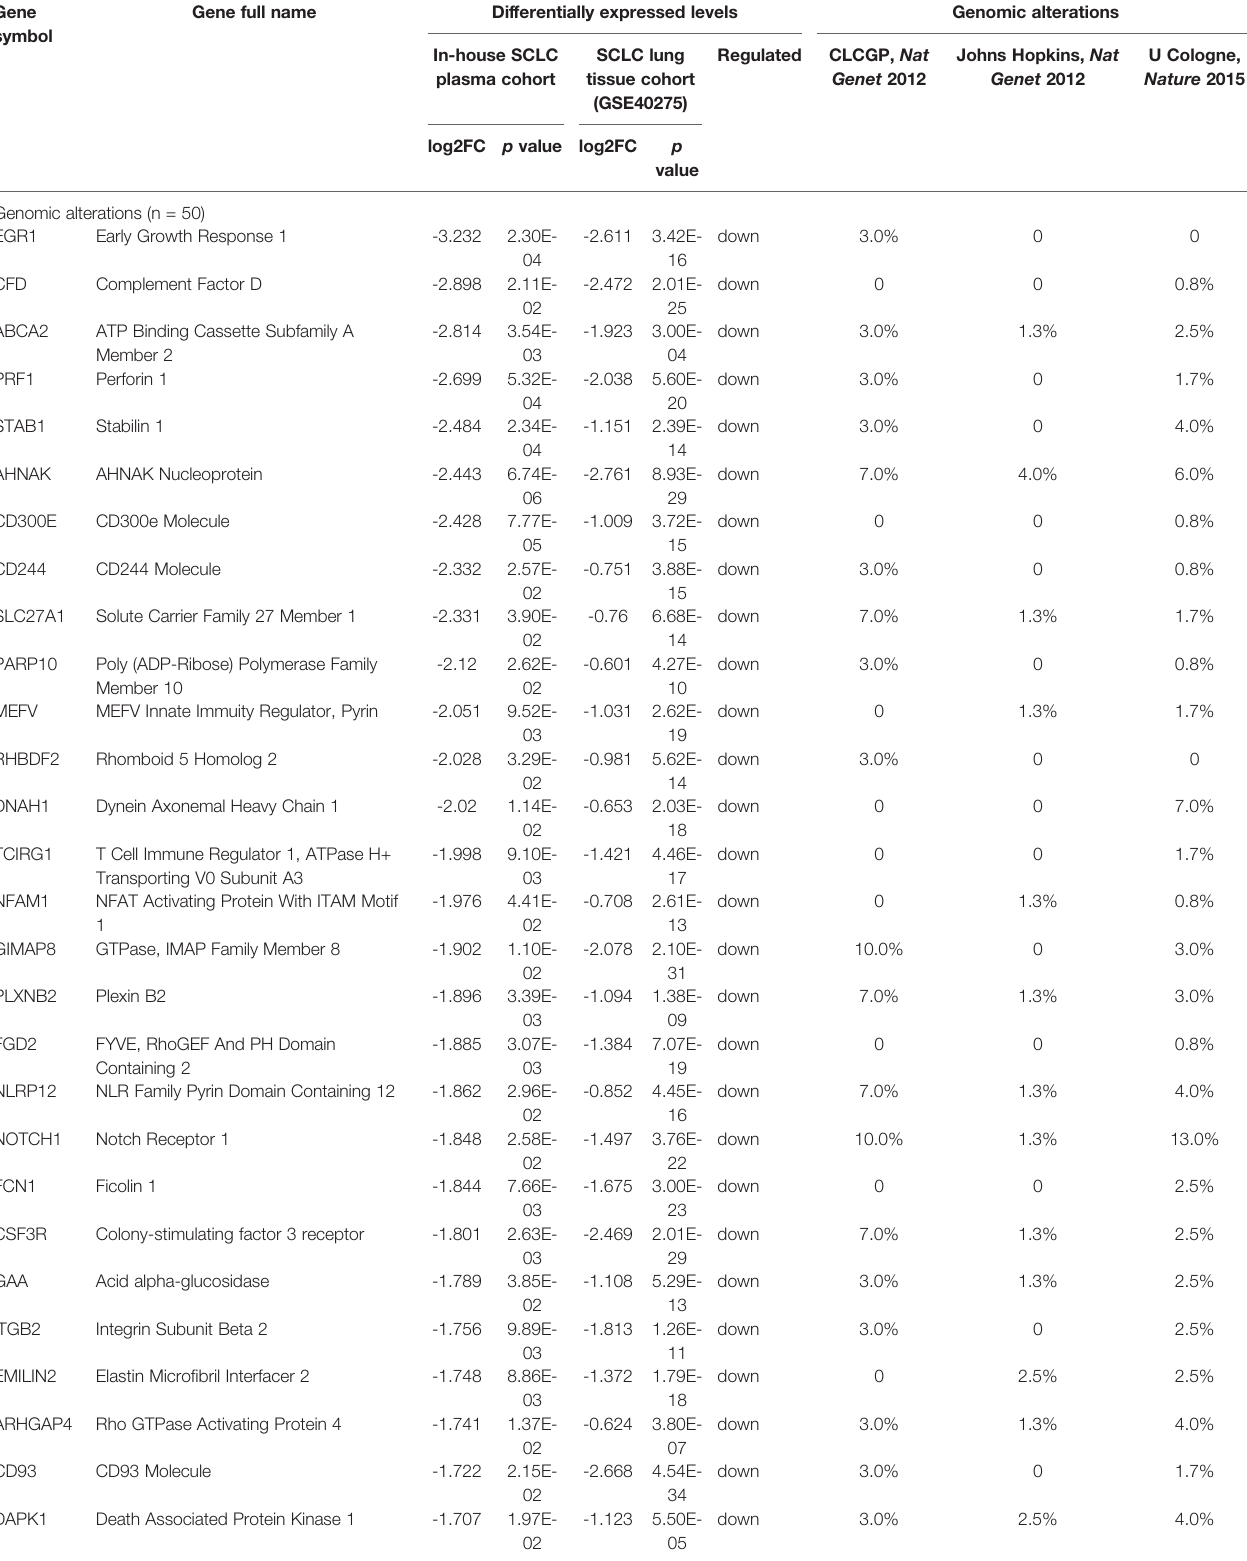
TABLE 2 | Differentially expressed levels and genomic alterations of mRNAs in the ceRNA regulatory network in